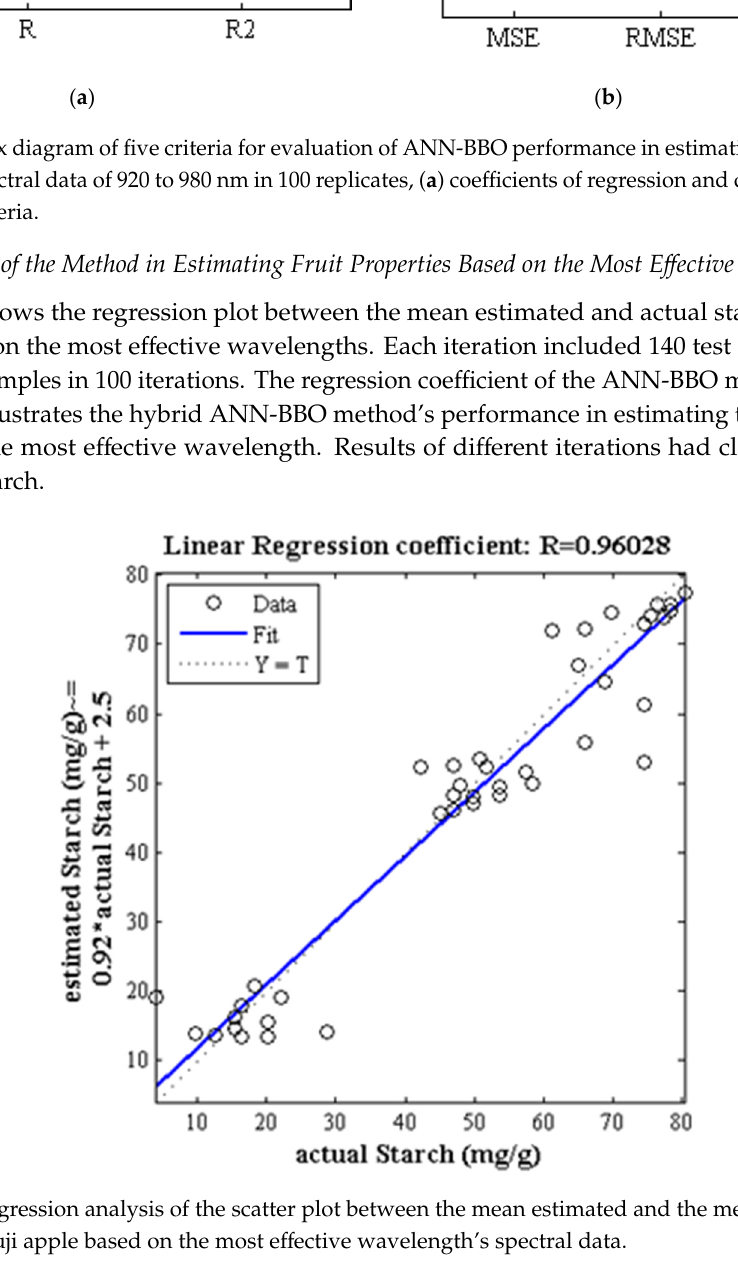
content in Fuji apple based on the most effective wavelength’s spectral data.